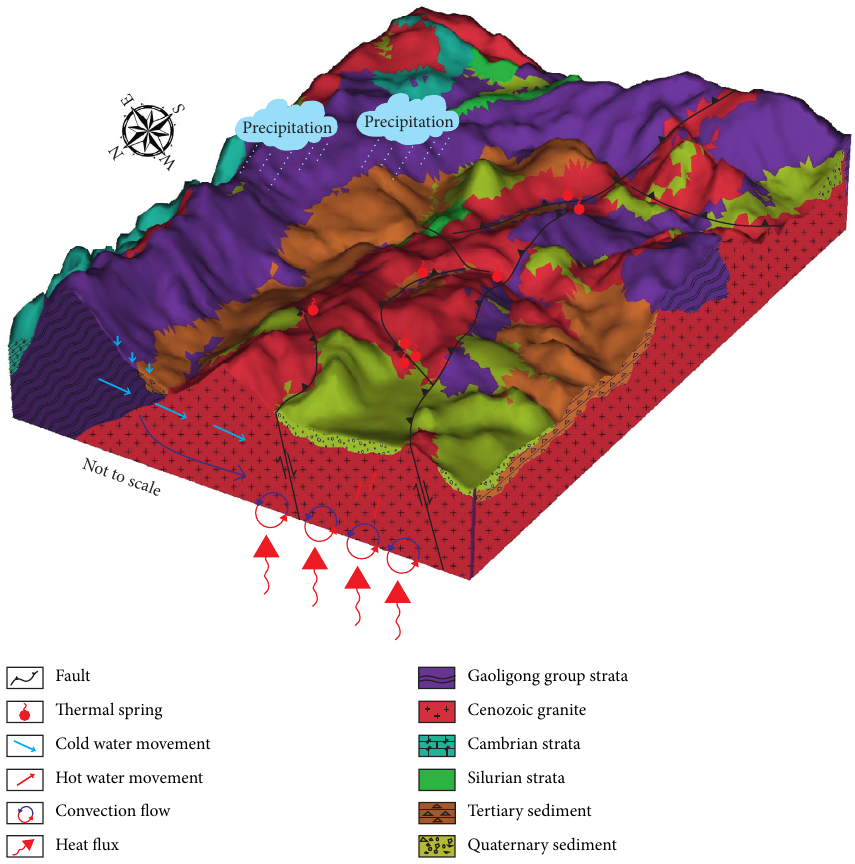
Figure 10: Conceptual model of low-temperature geothermal water in the Mangbang-Longling area.